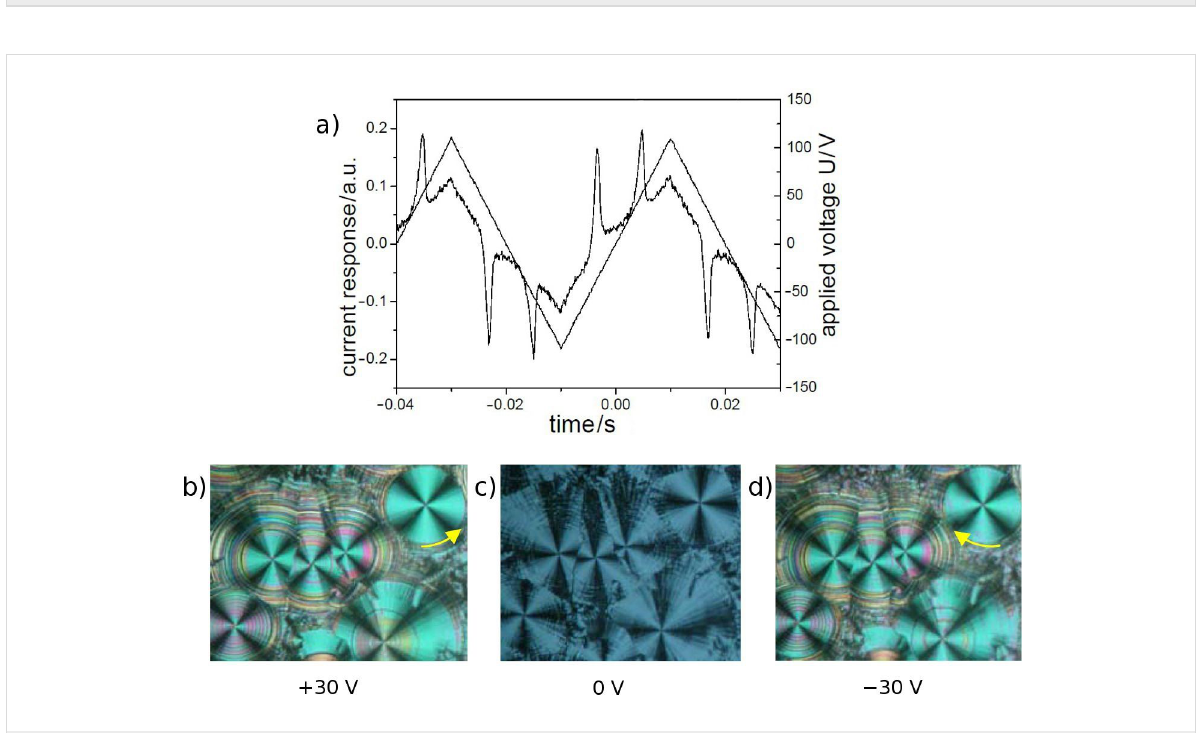
Figure 7: Electro-optical switching behaviour of compound OH 2a : a) current response ( U = 230 V pp , f = 25 Hz, T = 106 °C, d cell = 6 μ m; P S = 660 nC/cm 2 ); b–d) tristable switching on homogeneous chiral domains; starting from texture c) where the extinction crosses are parallel to the crossed polariser, the extinction crosses rotate anticlockwise in b) and clockwise in d) in dependence on the polarity of the D.C. electric